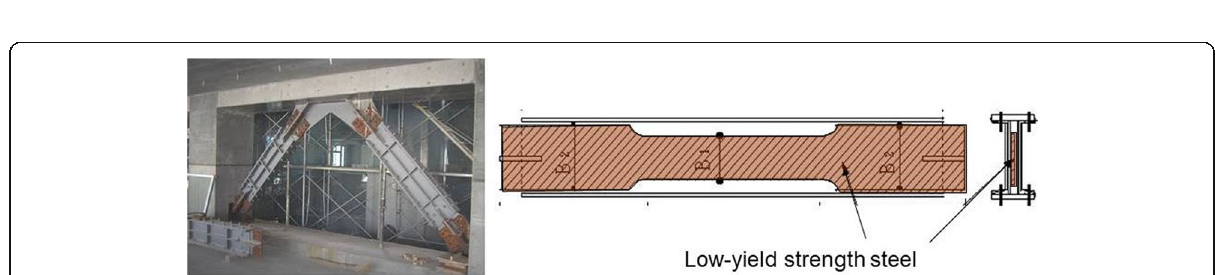
Fig. 16 Steel hysteretic damper using low-yield strength steel